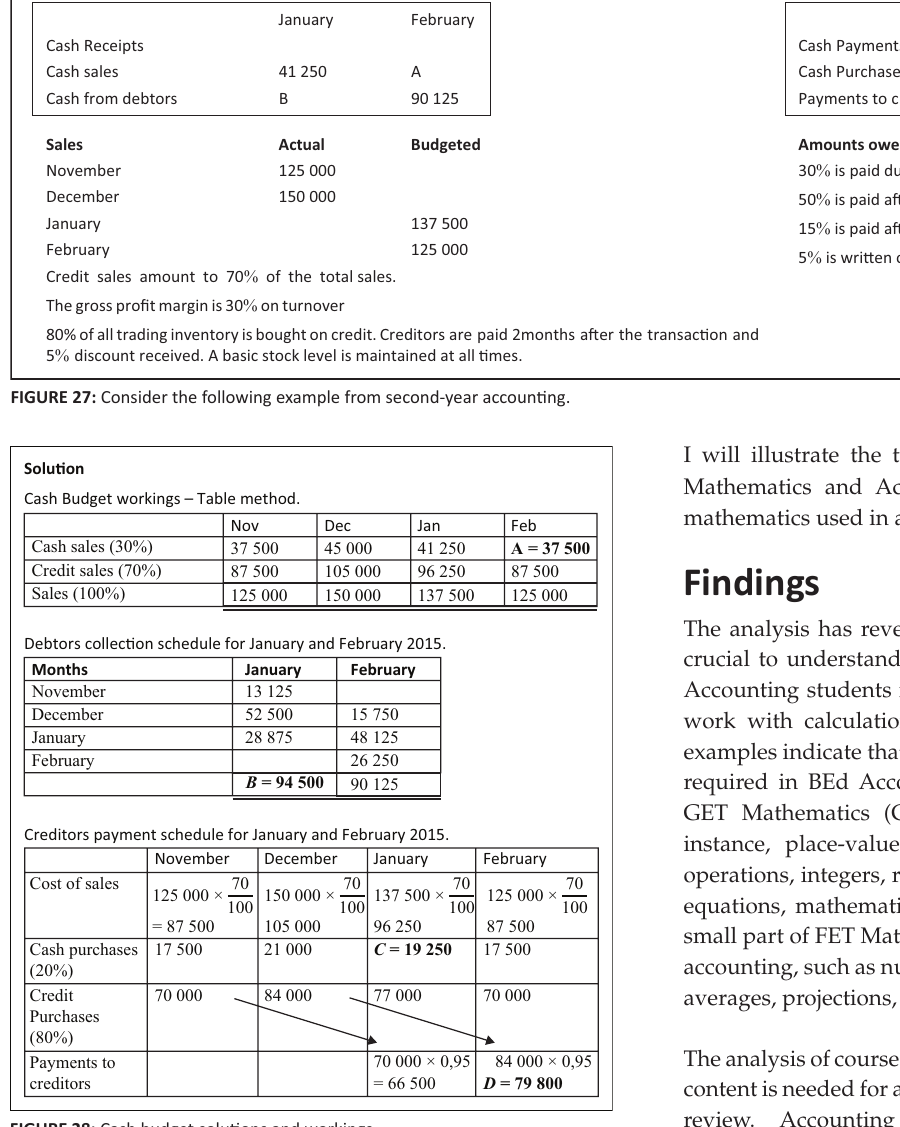
FIGURE 28: Cash budget solutions and